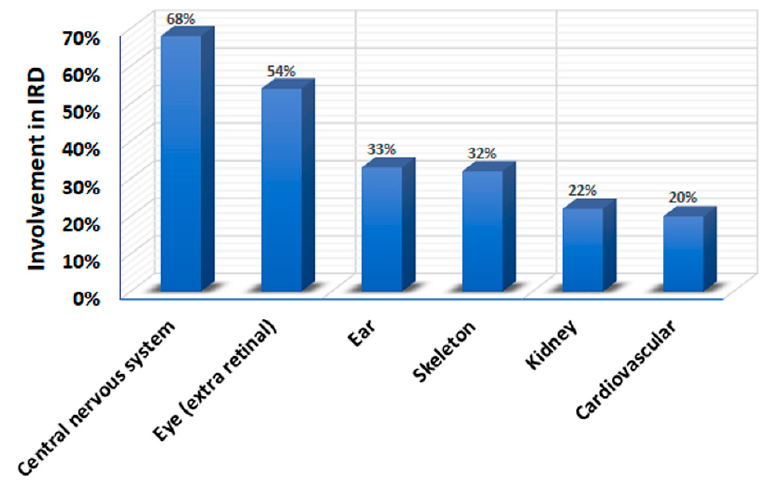
Figure 1. Systems and organs most commonly involved in syndromic IRDs.